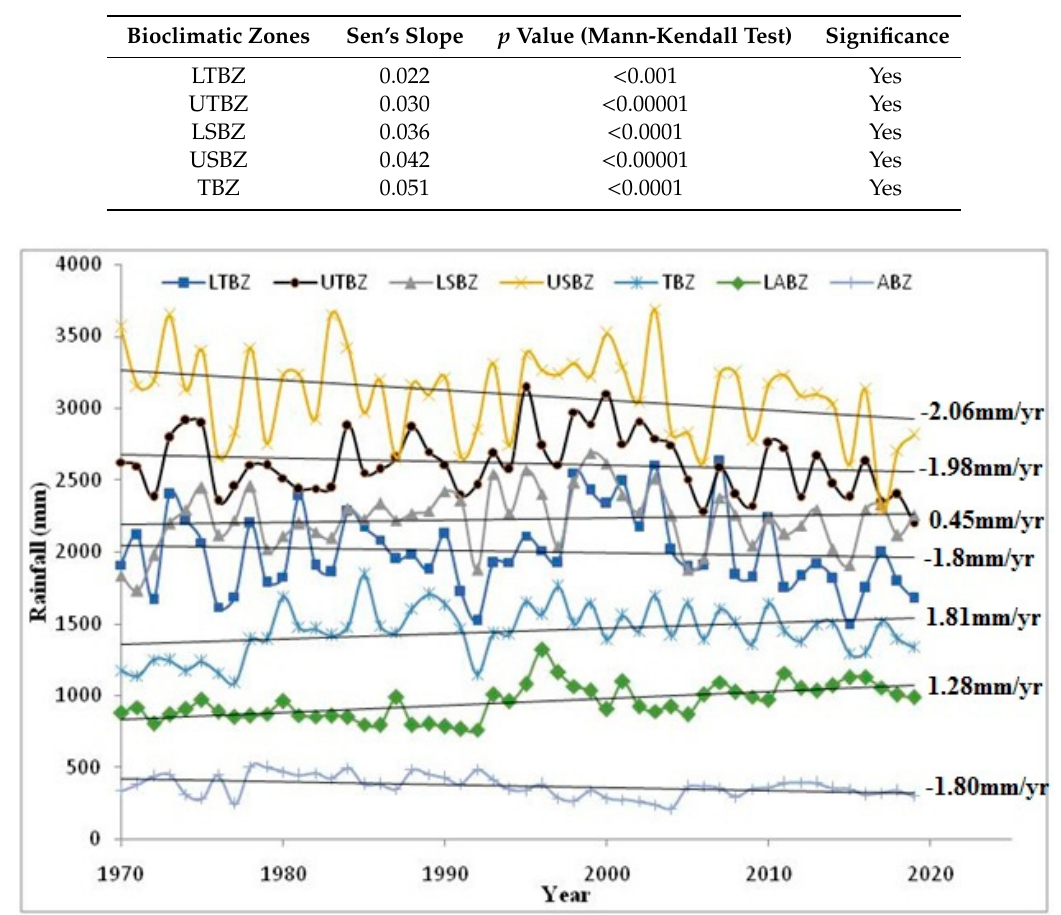
Figure 4. Average annual rainfall trends in different bioclimatic zones in CHAL.